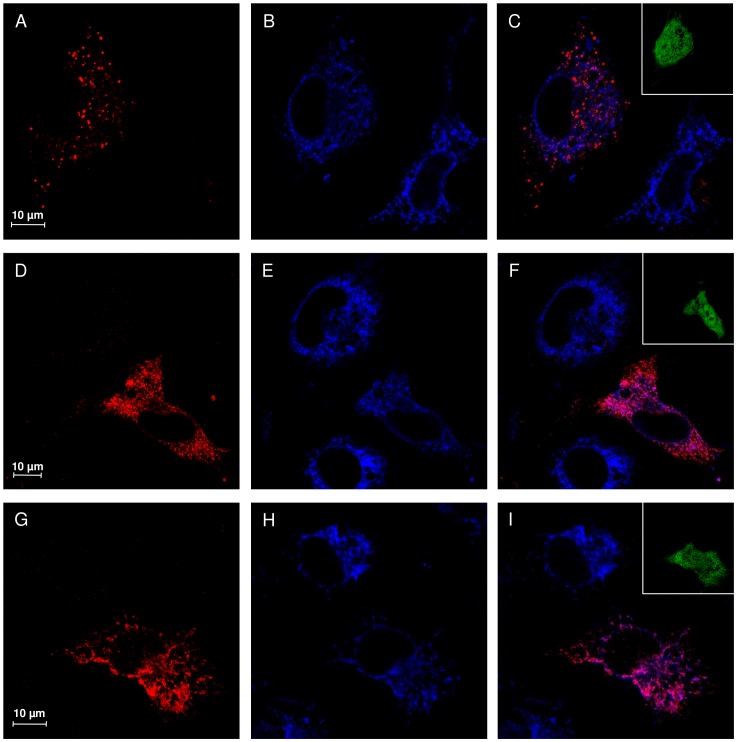
V217A and D234N NEU1 mutant proteins are accumulated in the ER.Confocal microscopy images showing the subcellular distribution of NEU1 wild-type, V217A and D234N mutants. NEU1 proteins were detected using specific rabbit anti-NEU1 antibody and revealed with Alexa-555 secondary antibody. Wild-type NEU1 labeling resulted in a vesicular pattern (A), with no evident colocalization with the ER marker PDI detected with mouse anti-PDI and revealed with Alexa-405 secondary antibody (B, merge in C). The V217A (D) and D234N (G) mutant proteins showed a tubulo-reticular localization with significant colocalization areas with PDI. Insets represent the GFP signal, indicating transfected cells. No evident leak of the green signal into the red or blue channel is detected.